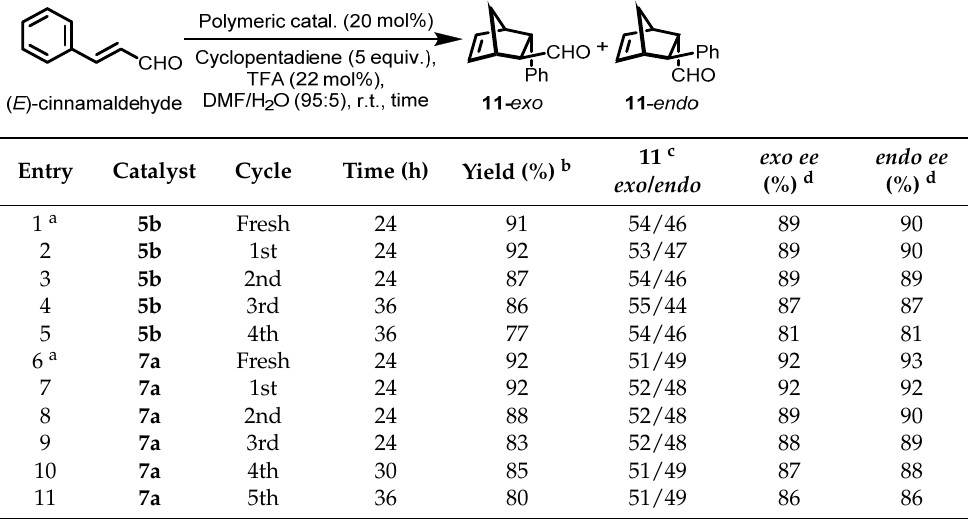
Table 8. Recycle use of polysulfate organocatalysts 5b and 7a in the asymmetric Diels–Alder reaction a .